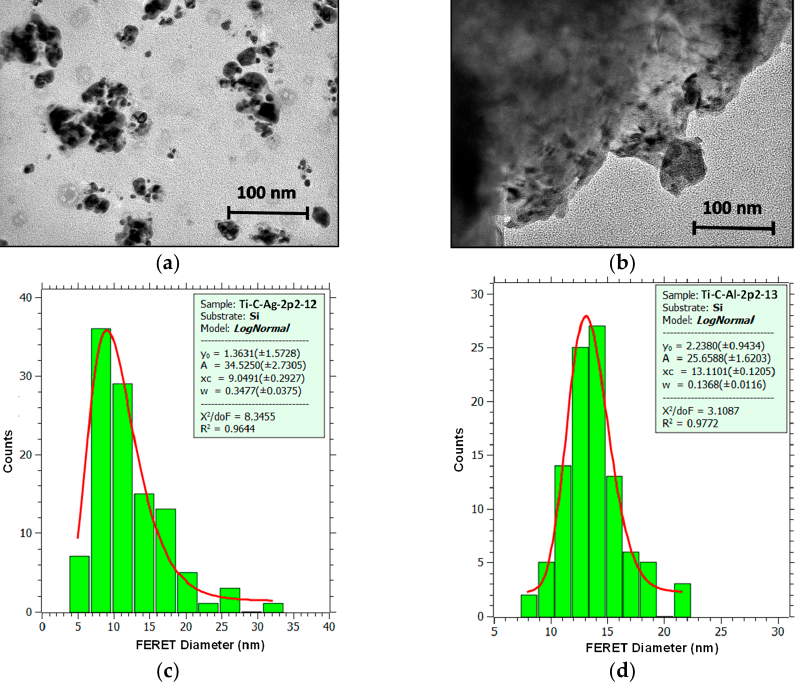
Figure 5. TEM images and grain size distribution and FERET diameters histogram of theTi-C-Ag/Si ( a , c ) and Ti-C-Al/Si ( b , d ).